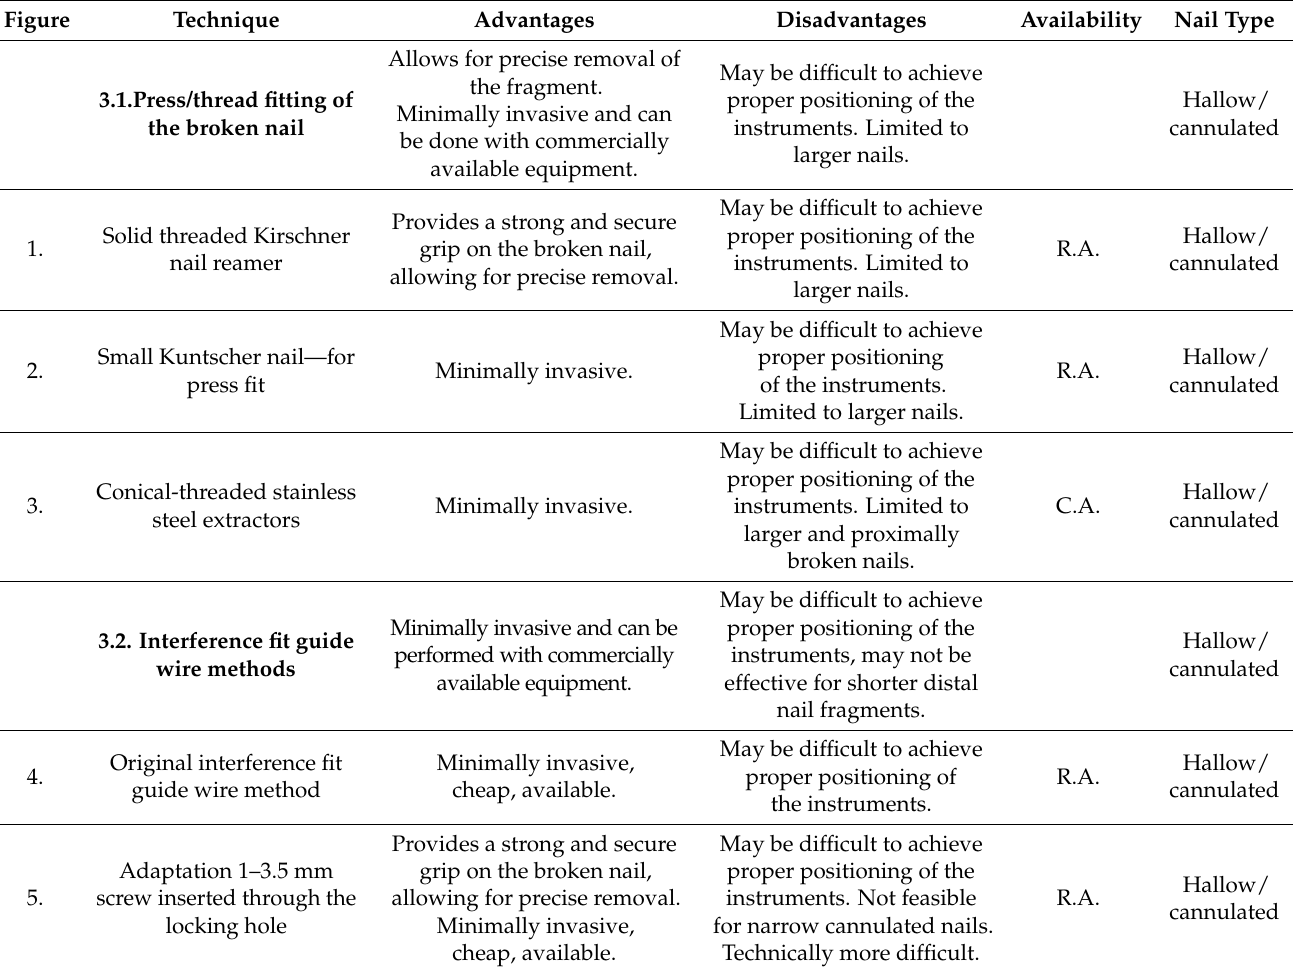
Table 1. Summary of the figures by categories. Short overview of the advantages and disadvantages of the techniques, of the availability of the instruments and tools (C.A.—commercially available; S.M.—self-manufactured; R.A.—readily available (that are usually available in an orthopedic depart- ment)) and of the nail type (hallow or solid) that it is can be addressed with each method.